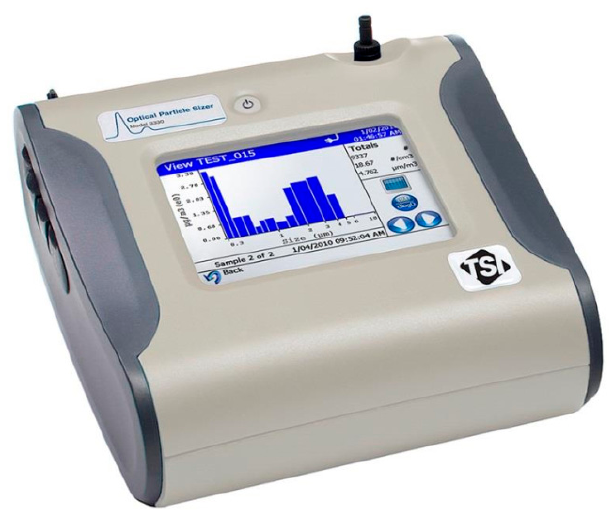
Figure 2. The TSI Optical Particle Sizer (OPS) Model 3330 [16].